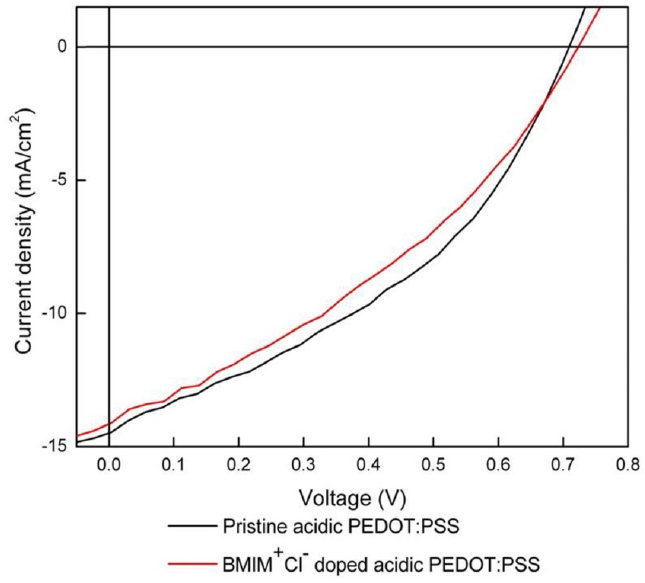
Figure 7. Current density–voltage (J–V) characteristics of PTB7:PCBM solar cells with pristine acidic PEDOT:PSS and BMIM + Cl − -doped acidic PEDOT:PSS as hole-transport layer (used with liquid EGaIn cathode).